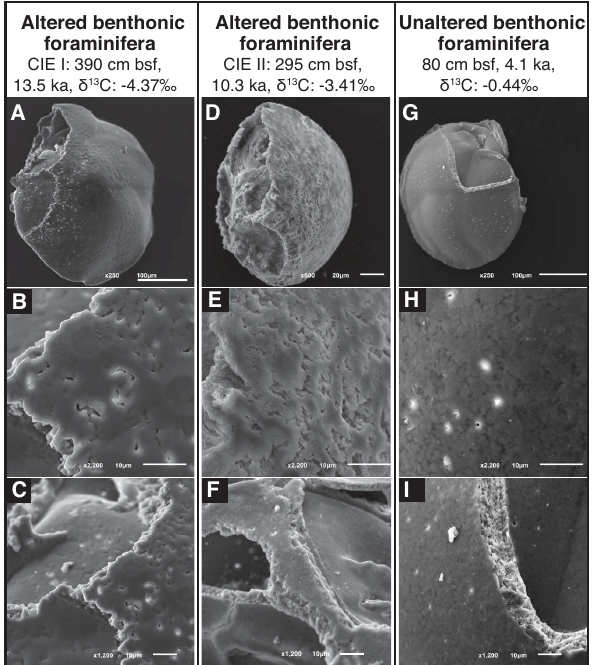
Figure 8. Representative SEM images of uncleaned C. neoteretis specimens from the depleted intervals ( a–c , from 390cmbsf; d–f , from 295cmbsf) and from an interval with normal 13 C values ( g–i , from 80cmbsf). (a) C. neoteretis test from the most depleted in- terval within CIE I ( δ 13 C: − 4.37‰, 13.5ka, 390cmbsf) showing a test with surface alteration by dissolution features. (b) Detail of pic- ture (a) where the external test shows enlarged pores (5–7µm) with irregular shapes. (c) Detail of picture (a) with a different magnifica- tion showing the irregular profile of the test wall. (d) C. neoteretis from CIE II interval ( δ 13 C: − 3.41‰, 10.3ka, 295cmbsf) showing a test with surface alteration characterized by dissolution features. Note the smaller scale of the picture. (e) Detail of picture (d) where the enlarged and irregular shaped pores are widespread. (f) Detail of the test of a different specimen from the same interval where the sur- face alteration is less evident but the profile of the test walls is quite irregular. (g) C. neoteretis from an interval with normal 13 C val- ues ( δ 13 C: − 0.44‰, 4.1ka, 80cmbsf) showing a well-preserved test with pristine shell structure. (h) Detail of picture (g) showing small (<1µm) and round-shaped pores with no alteration features. (i) Detail of picture (g) with a different magnification showing a well-preserved test and regular profile of the test wall. Picture mag- nifications and length of the white bar are indicated in each